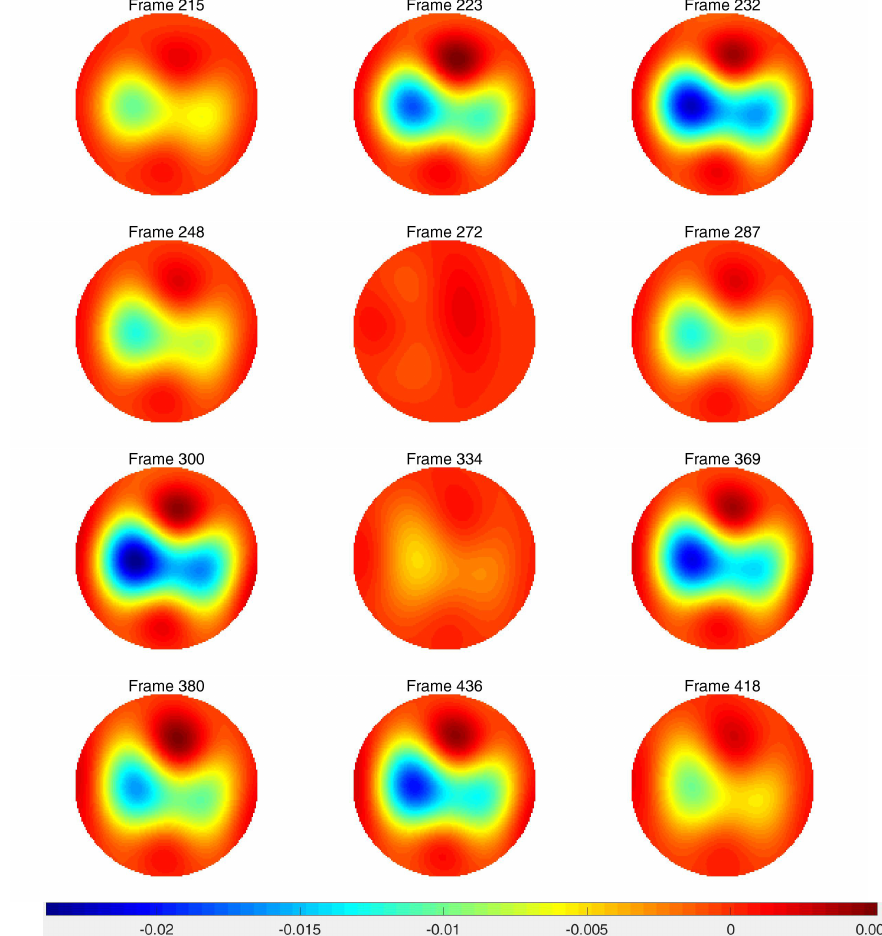
Figure 14. Difference images of ventilation data with modeling the domain to be a circle. No prior is added. Frame 200 is used for the reference image. The truncation radius is